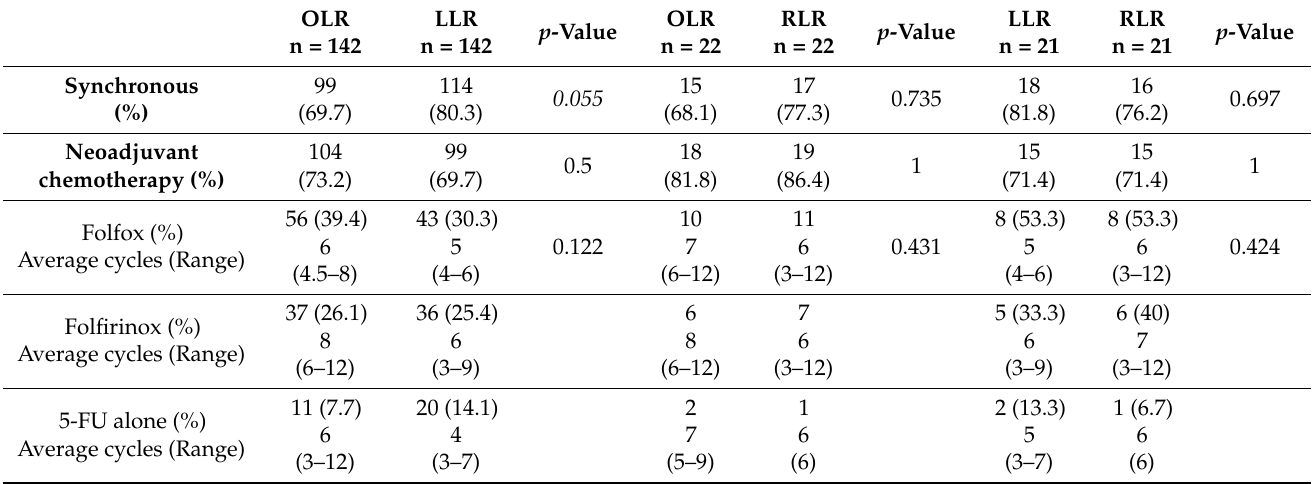
Table 1. Oncological factors of open liver resection (OLR) vs. laparoscopic liver resection (LLR), open liver resection (OLR) vs. robotic liver resection (RLR) and laparoscopic liver resection (LLR) vs. robotic liver resection (RLR), including the type of neoadjuvant chemotherapy and biological